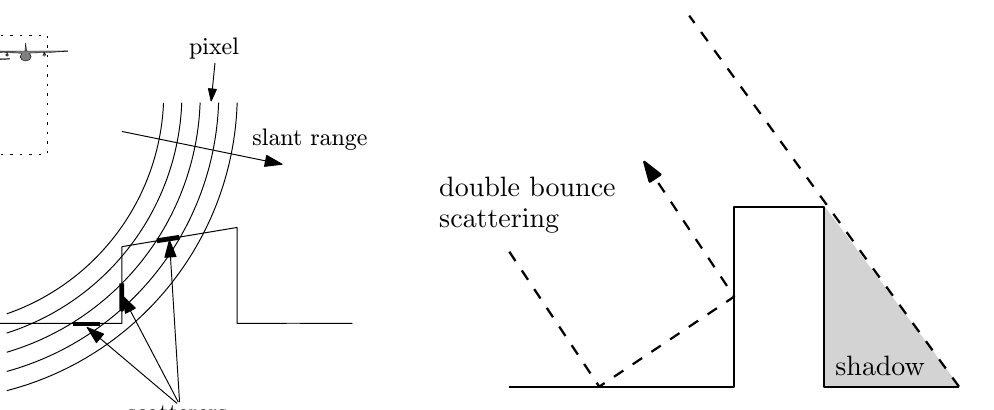
Figure 5: Example of other artifacts in SAR data. Multiple bounce and shadow occur (here we show the example of double bounce between a ground and a